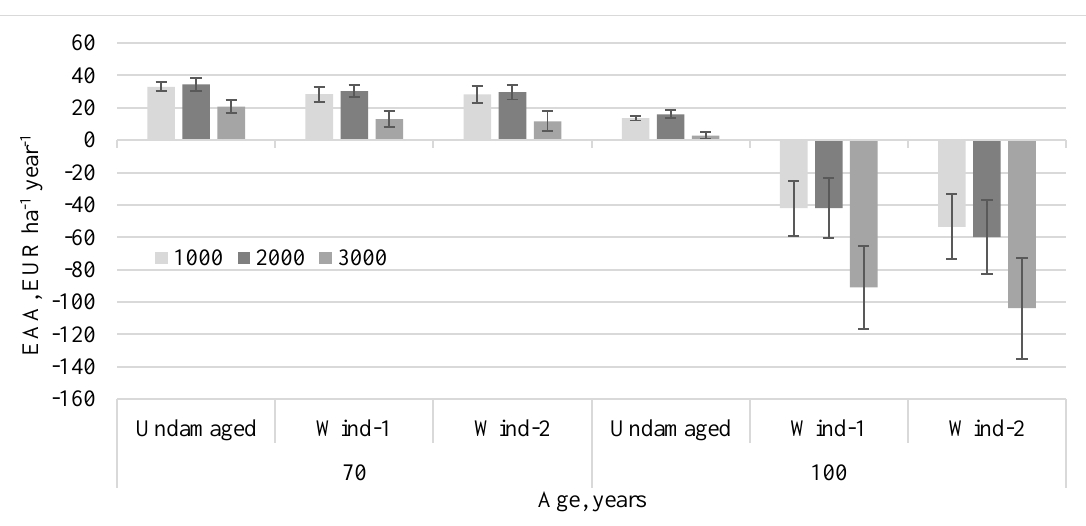
Figure 4. Equivalent annual annuity (EAA, r = 4%) for the undamaged Scots pine stands (SI 36) and stands in mild wind conditions (Wind-1) and the windiest conditions (Wind-2), depending on the initial planting density (1000–3000 trees ha − 1 ). Whiskers denote the 95% confidence intervals of the EAA.